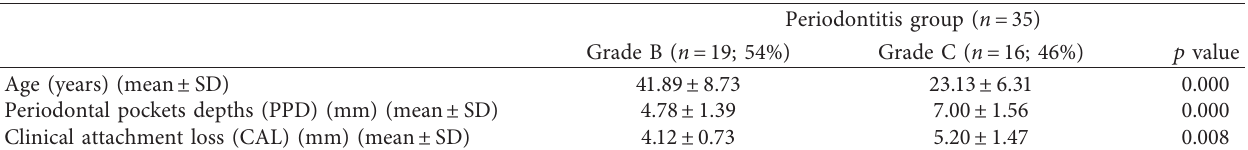
Table 3: Comparison of clinical parameters in the periodontitis group according to grade B and grade C.